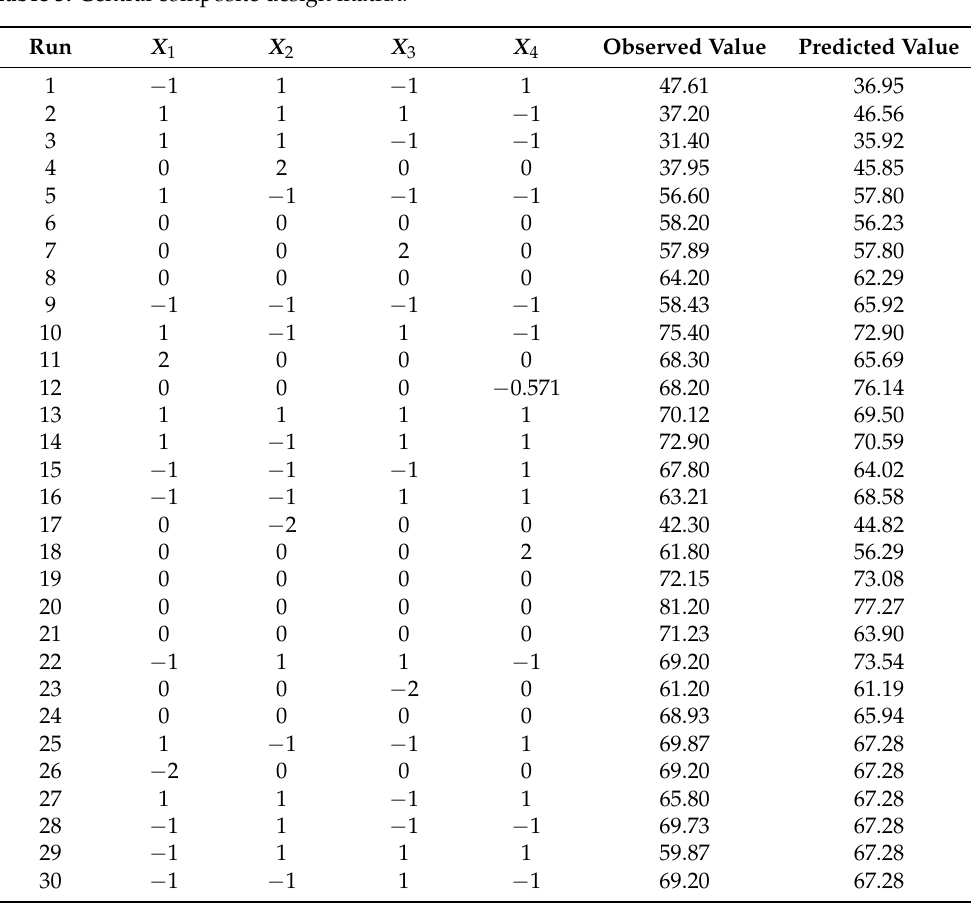
Table 3. Central composite design